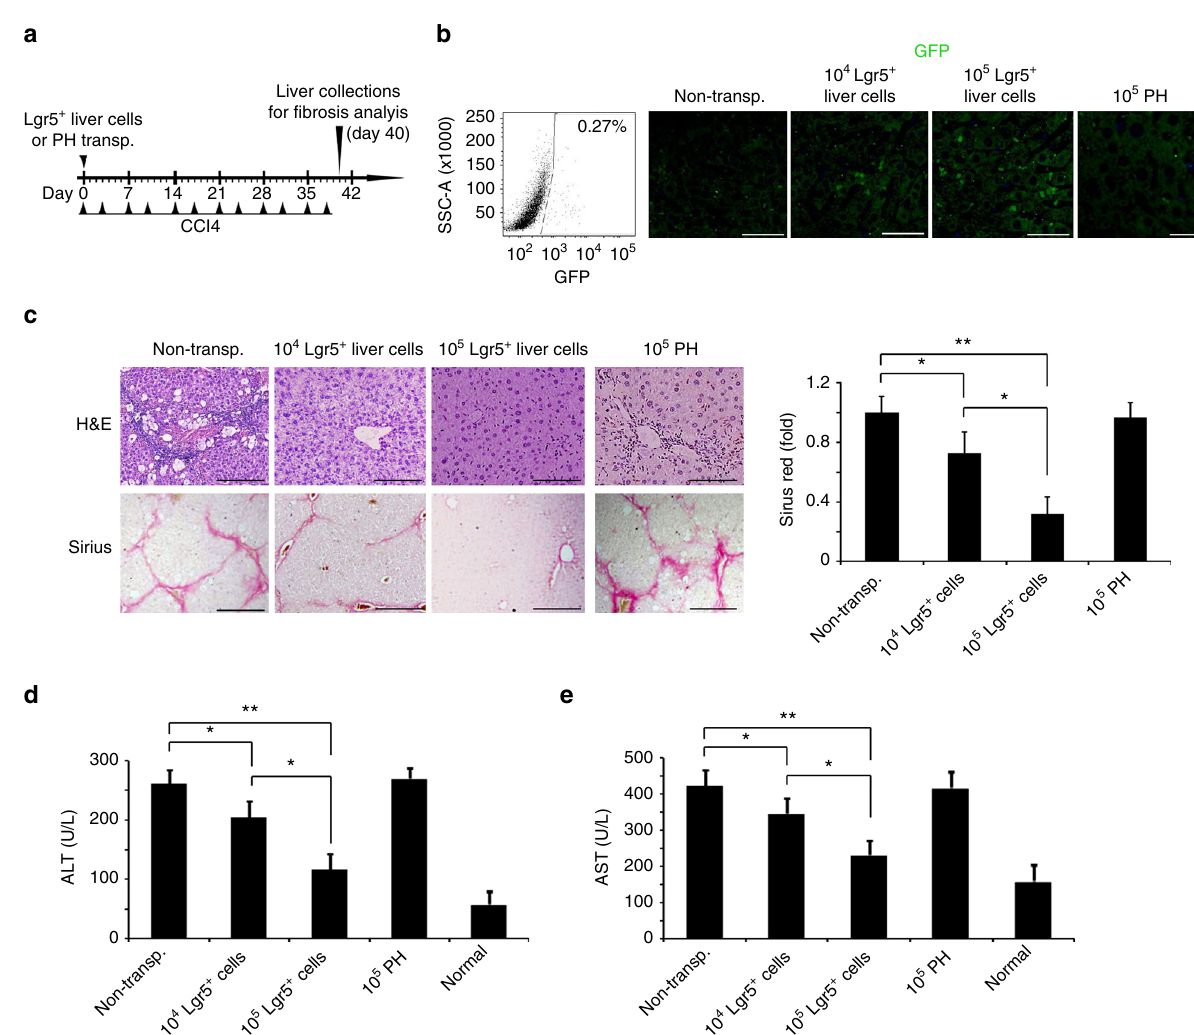
Fig. 1 Lgr5 + liver stem cells transplantation decreased liver fi brosis. a Schematic overview of the experimental setup. Eight-week-old wild-type C57 mice were i.p. injected with CCL4 (2 ml/kg, Sigma-Aldrich) dissolved in olive oil at a ratio of 1:4, or olive oil alone (2 ml/kg) twice a week for 6 weeks. Lgr5-GFP + liver stem cells or primary hepatocyte (PH) derived from Lgr5-GFP mice were transplanted into the liver fi brosis mice by intrasplenical injection on day 0. b Lgr5 + cells were isolated from Lgr5-GFP mice treated with CCL4 by FACS assay for transplantation (left). The liver Lgr5 expression was stained using anti-GFP antibody in mice with Lgr5 + cells or PH transplantation (right) on day 40. n = 10 mice, scale bars, 200 μ m. c , d Lgr5 + liver stem cells transplantation decreased CCL4-induced liver fi brosis and recovered liver functions. Lgr5-GFP + liver stem cells or PH transplantation were described in a ; the livers were harvested and stained using H&E and Sirius Red for fi brosis analysis and quanti fi cation of positive-staining areas measured by Image J software ( c ). The serum was harvested for ALT and AST analysis ( d , e ). For c , scale bars, 200 μ m, the results are shown as mean ± s.d. of fi ve independent sections taken randomly per mice and a total of 50 tissue specimens in each group ( n = 10 mice) * p < 0.05, ** p < 0.01. For d , e , triplicates for each condition were analyzed. The results are shown as mean ± s.d. of three independent experiments. * p < 0.05, ** p <